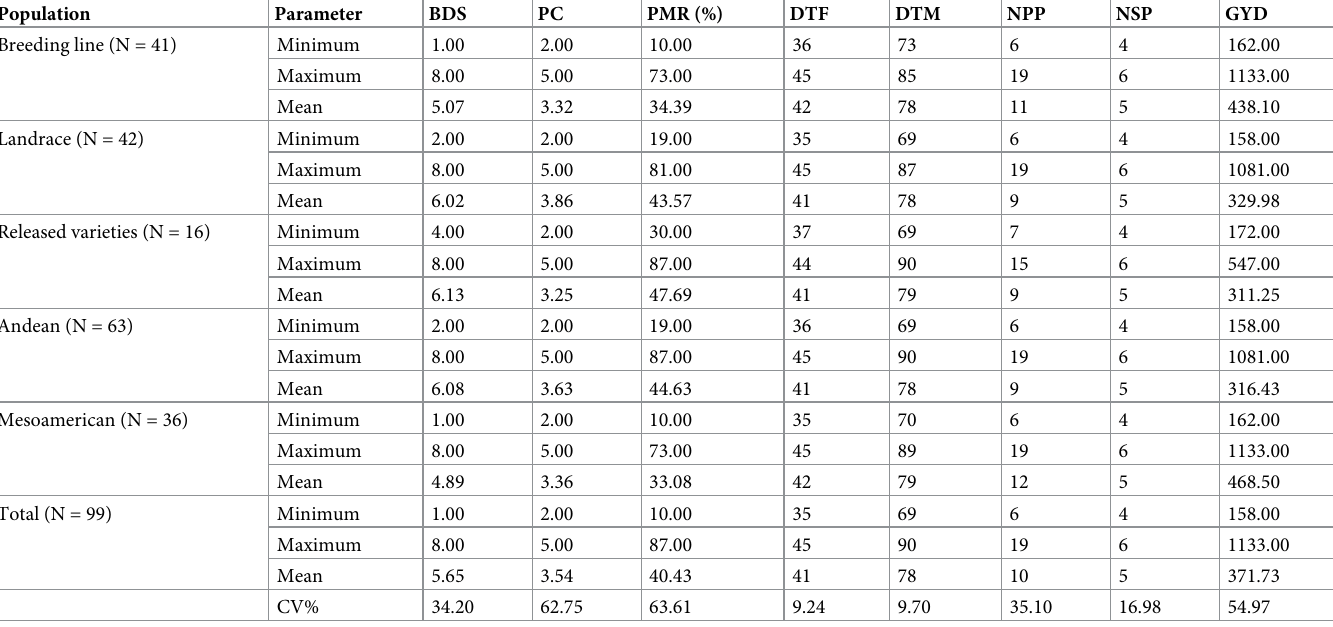
Table 2. Summary statistics for three bean fly resistance parameters and five agronomic traits when evaluating 99 common bean genotypes in two locations (Chit- edze and Mbawa research stations) and two years (2018 and 2019) in Malawi.